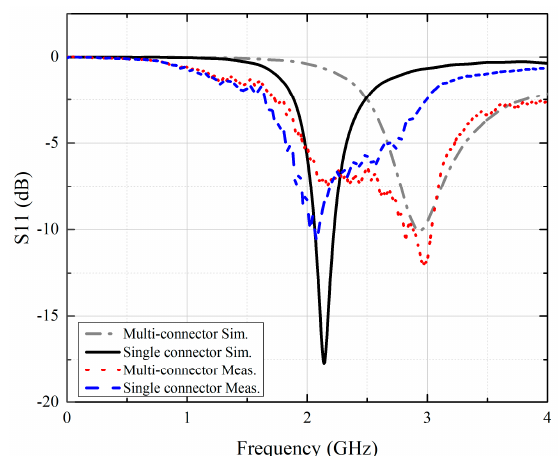
Figure 12. The simulated and measured reflection coefficients of the multi-connector and single- connector stent antennas.